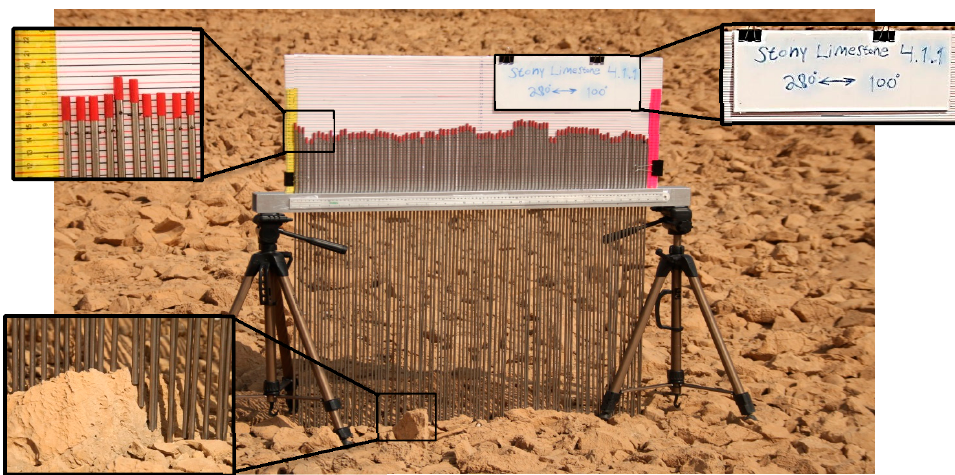
Figure 4. The profilometer as used in the field to measure a stony dolomitized limestone unit. The tips of the 101 rods are colored red to increase contrast from the background. The outcome provides a replica of the surface height variability at 1-cm horizontal spacing.